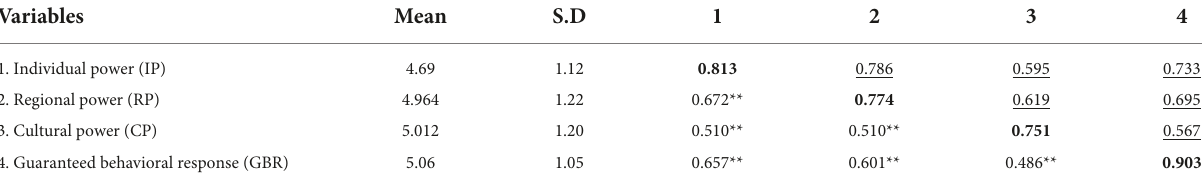
TABLE 4 Discriminant validity–Fornell–Larcker criterion and Heterotrait–Monotrait ratio.